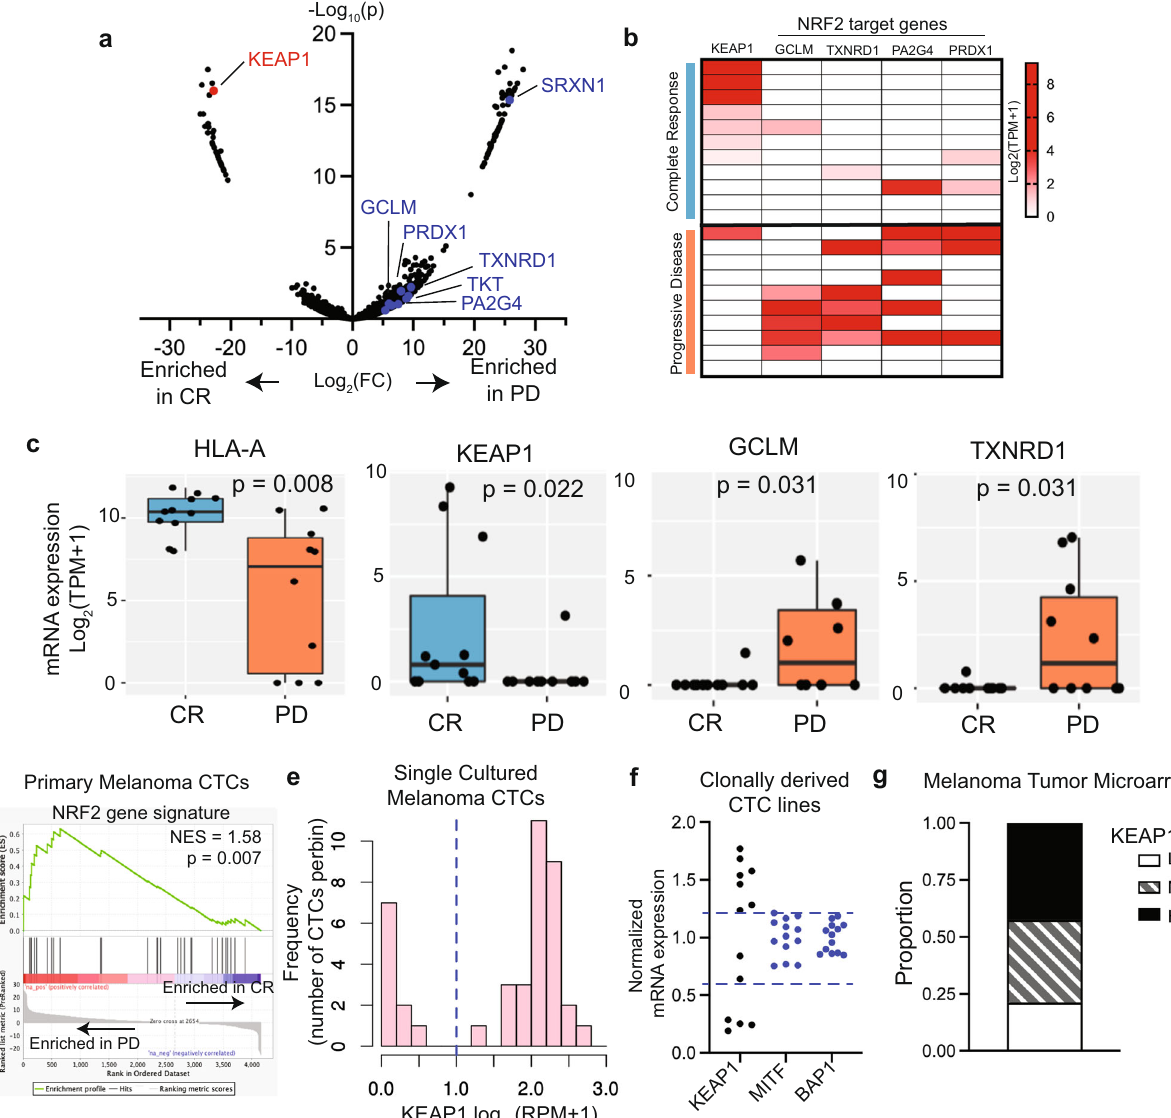
Fig. 1 Low KEAP1 expression is associated with poor response to immune checkpoint blockade. a Volcano plot showing baseline gene expression within patient-derived single CTCs correlated with subsequent ICB complete response (CR; 11 CTCs) or progressive disease (PD; 10 CTCs). KEAP1 enriched in CR is labelled (red) and NRF2 target genes enriched in PD are labelled (blue). b Heatmap showing expression of KEAP1 and the NRF2 target genes GCLM, TXNRD1, PA2G4 and PRDX1 , in primary CTCs derived from patients with complete response (CR) or progressive disease (PD) following ICB. c Bar graphs showing the baseline expression of HLA-A , KEAP1 , and the NRF2 target genes GCLM and TXNRD1 , in freshly isolated CTCs derived from patients with subsequent complete response (CR) or progressive disease (PD) following ICB. Line represents the median value, box spans 25th to 75th percentile, and whiskers span 5th to 95th percentile. P value determined by Wilcoxon rank sum test. d Gene set enrichment plots showing enrichment of the NRF2 gene signature in CTCs from patients with PD. e Histogram showing single cell heterogeneity in KEAP1 mRNA expression across cultured CTCs, all isolated from melanoma patient MEL167. KEAP1 mRNA quantitated using scRNAseq (RPM). f Plot showing variability in mRNA expression of KEAP1 , compared with the melanoma lineage markers MITF and BAP1 , in single cell-derived clonal sublines of MEL167 CTCs. g Quanti fi cation of KEAP1 staining of melanoma tumor microarrays ( n = 33 tumors). Tumors were categorized as high, medium, and low by setting intensity bins that span equal thirds of the total range of intensity